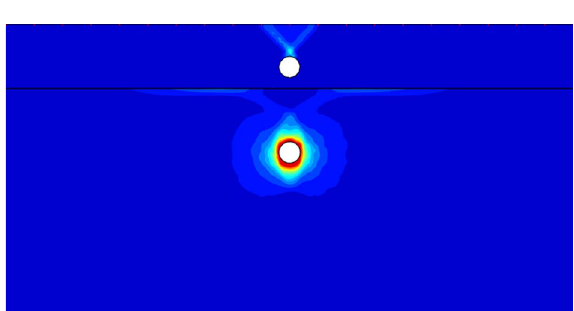
Figure 12. The UB failure mechanism of c u1 / c u2 = 3, X / D = 0, Y / D = 4.